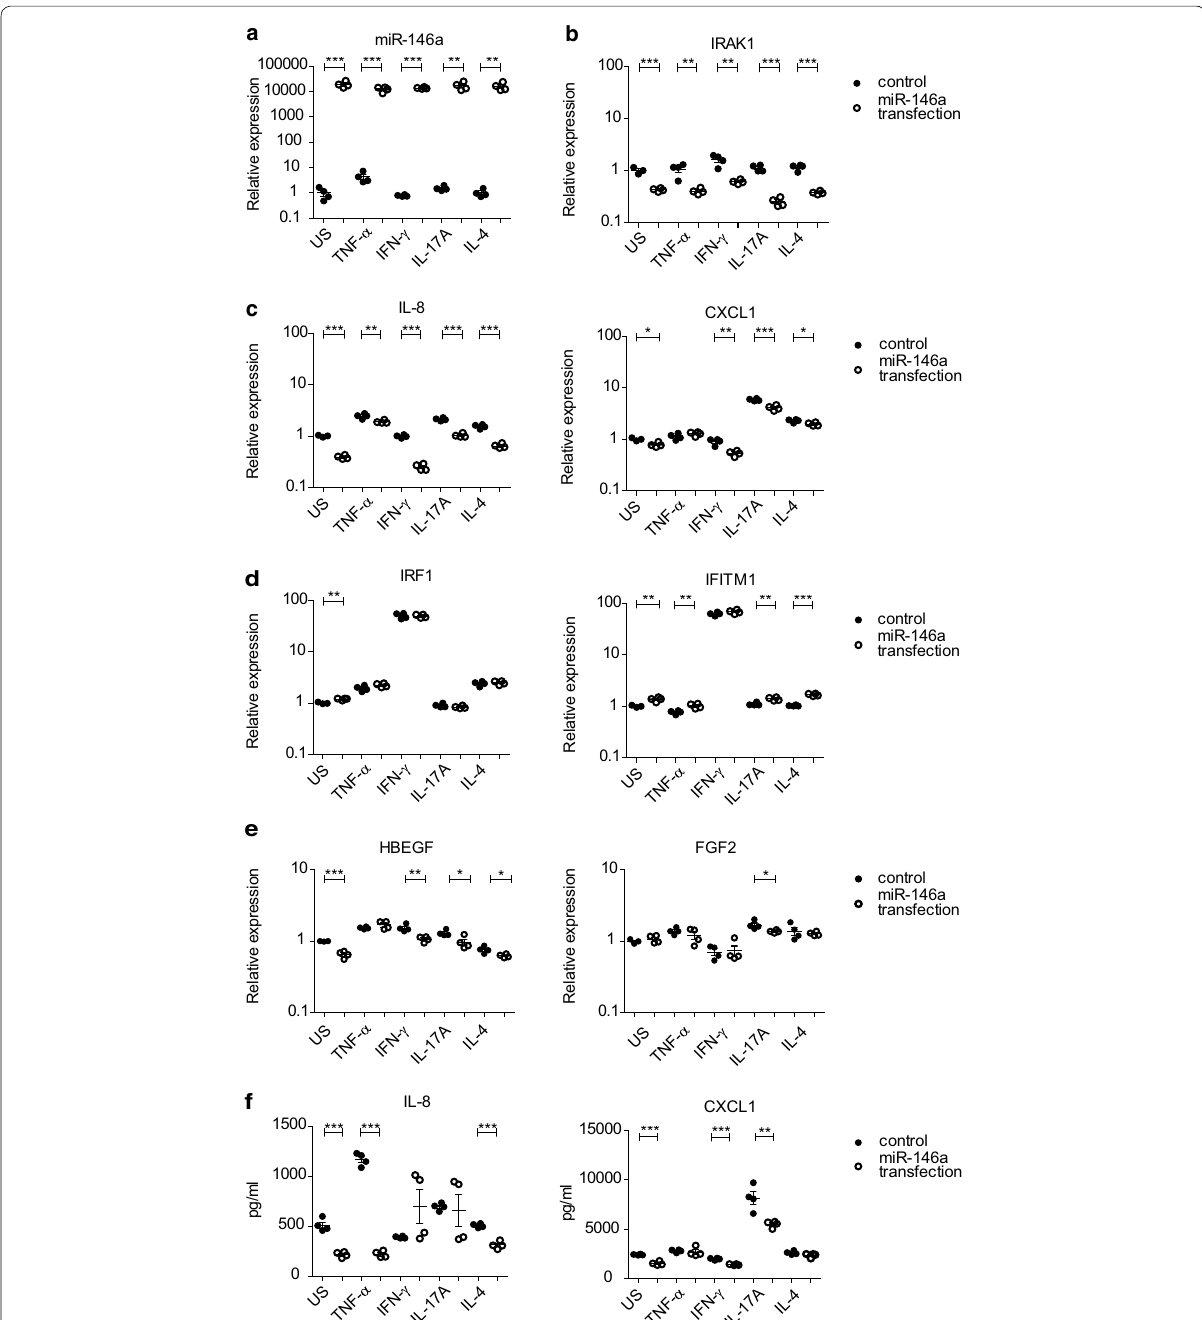
Fig. 4 miR-146a inhibits the expression of pro-inflammatory chemokines IL-8 and CXCL1 and moderately upregulates interferon response genes. HBECs were transfected with miR-146a or control mimic and 24 h later stimulated with indicated cytokines or left unstimulated (US) for 48 h until harvesting. Relative miR-146a expression ( a ) and mRNA ( b–e ) expression was measured by RT-qPCR. ( f ) Protein levels of IL-8 and CXCL1 from the supernatants of transfected and stimulated HBECs were measured by ELISA. Data represent mean ***P <